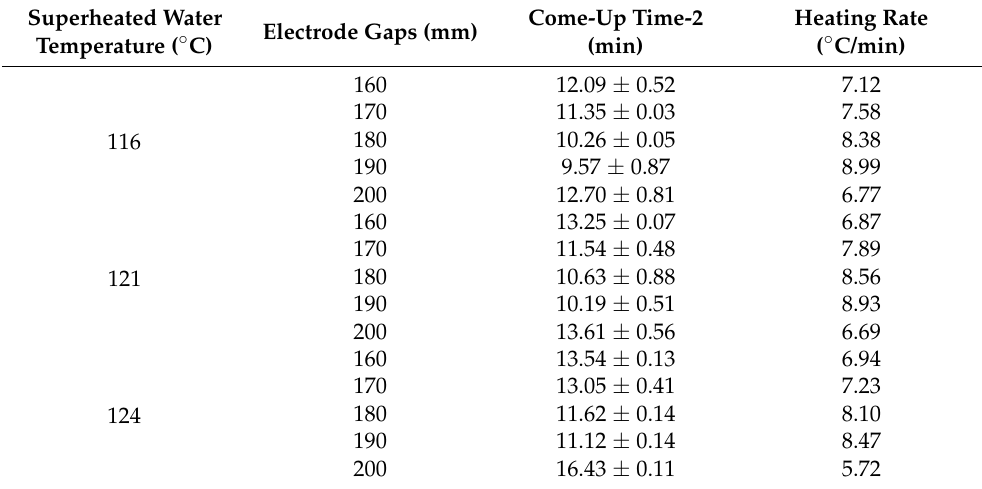
Table 2. Come-up time and heating rate from 30 ◦ C to superheated water set temperature at different electrode